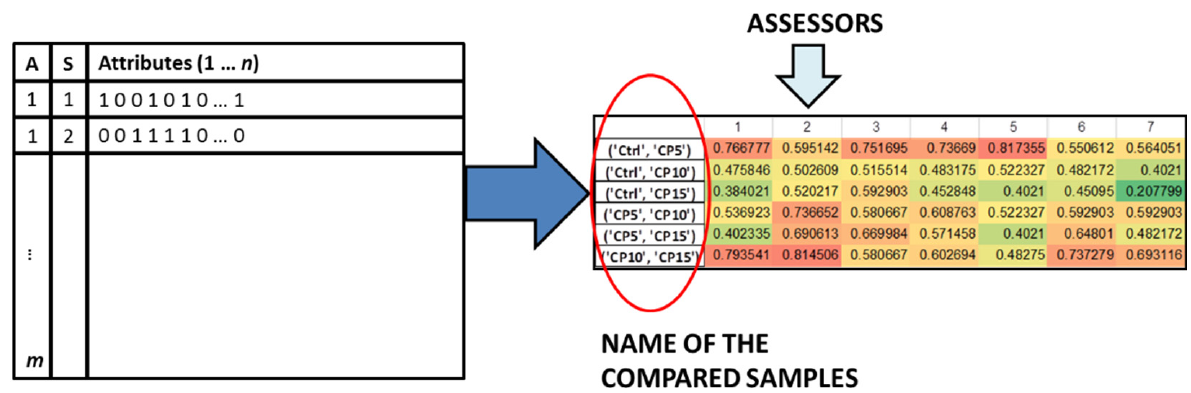
Figure 1. The workflow of the calculation of similarity metrics from CATA experiments. Assessors are marked with “A” and Samples are marked with “S” in the left side of the plot, with “n” being the number of attributes and “m” the number of assessors.